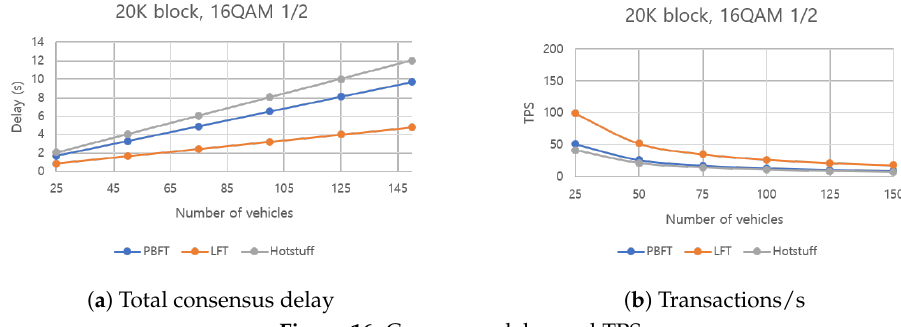
Figure 16. Consensus delay and